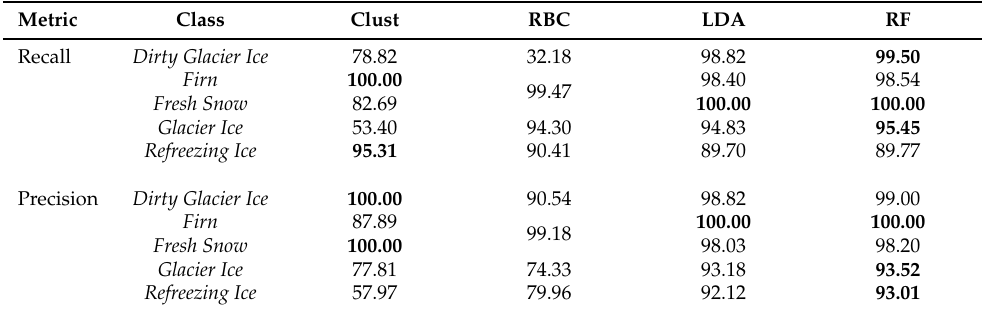
Table 4. Comparison of the scores achieved by the applied classification approaches for the class-wise evaluation metrics of recall and precision with values in % (Clust: k-means clustering with k = 8; RBC: Rule-based classification; LDA: Linear Discriminant Analysis; RF: Random Forest).